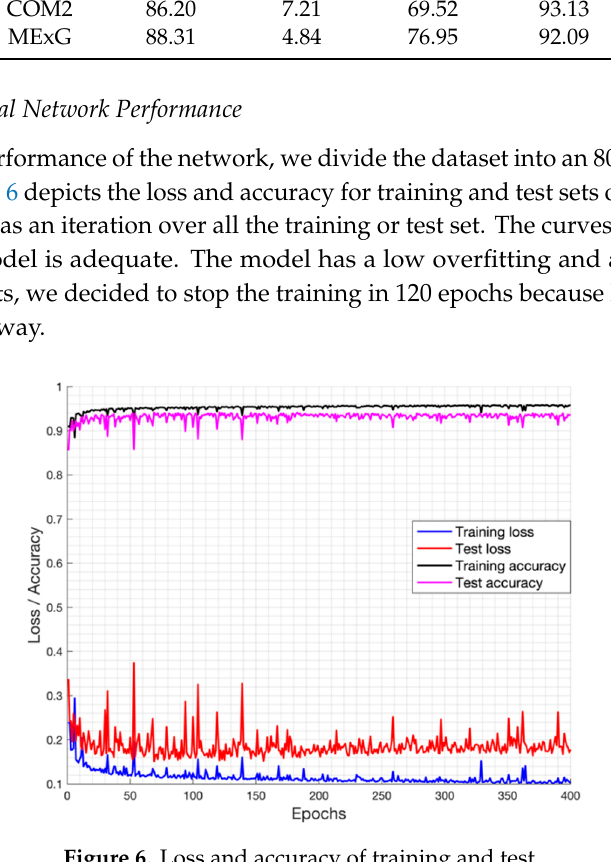
Figure 6. Loss and accuracy of training and test.